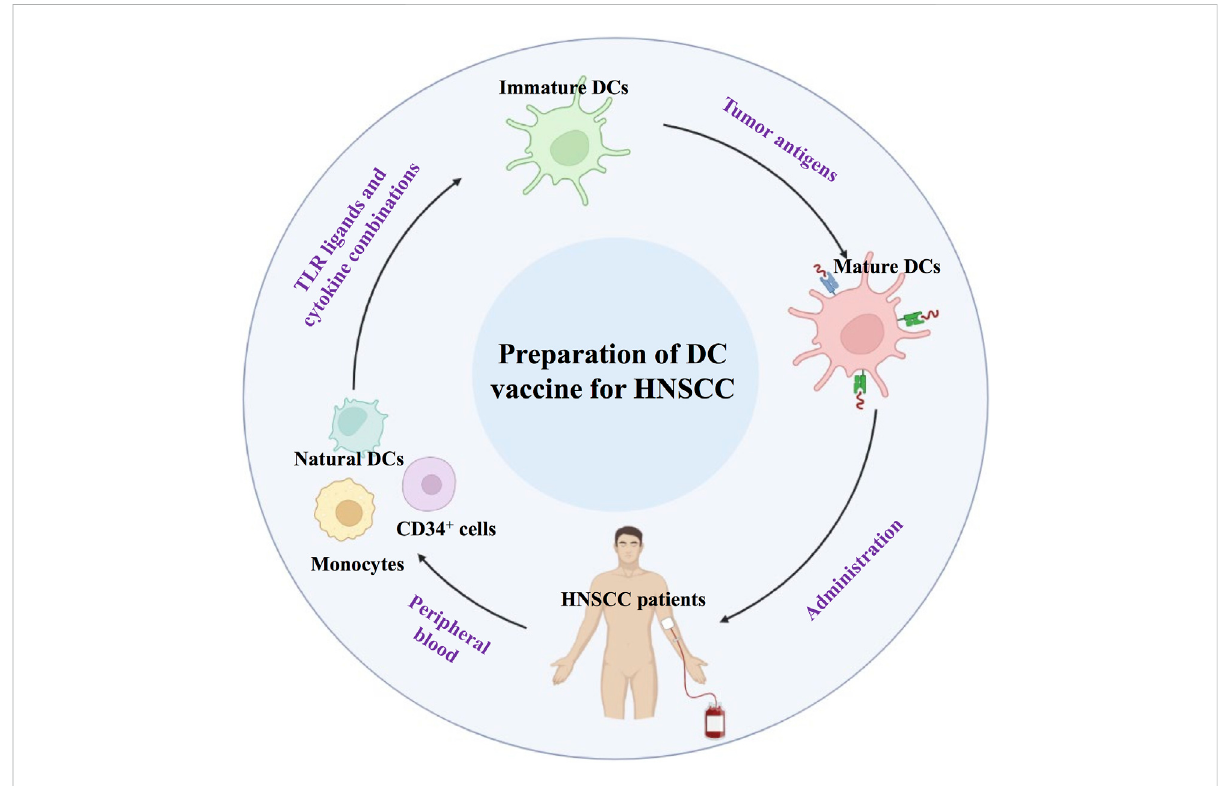
Schematic diagram of applying DC-based vaccination in